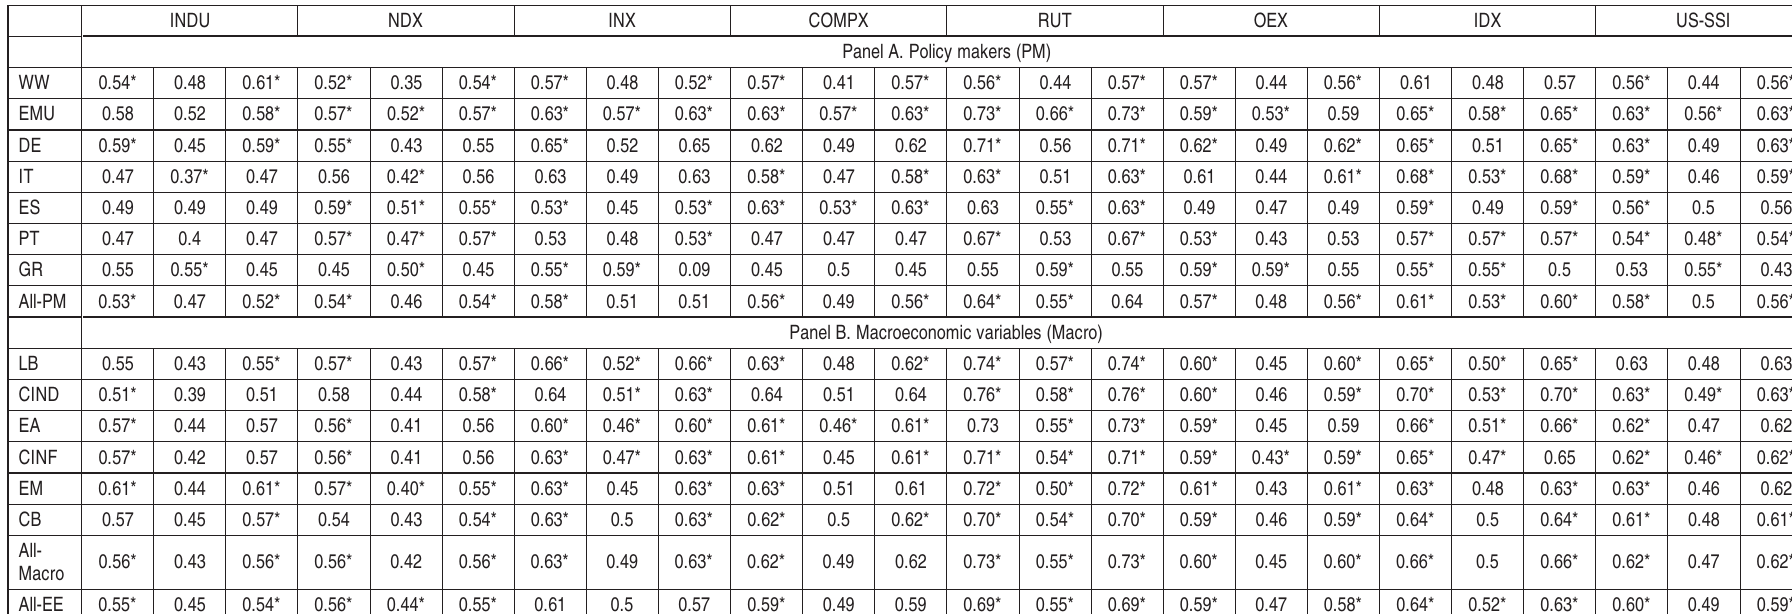
Table 11. Jump frequency criterion - US stock spot indices (US-SSI)